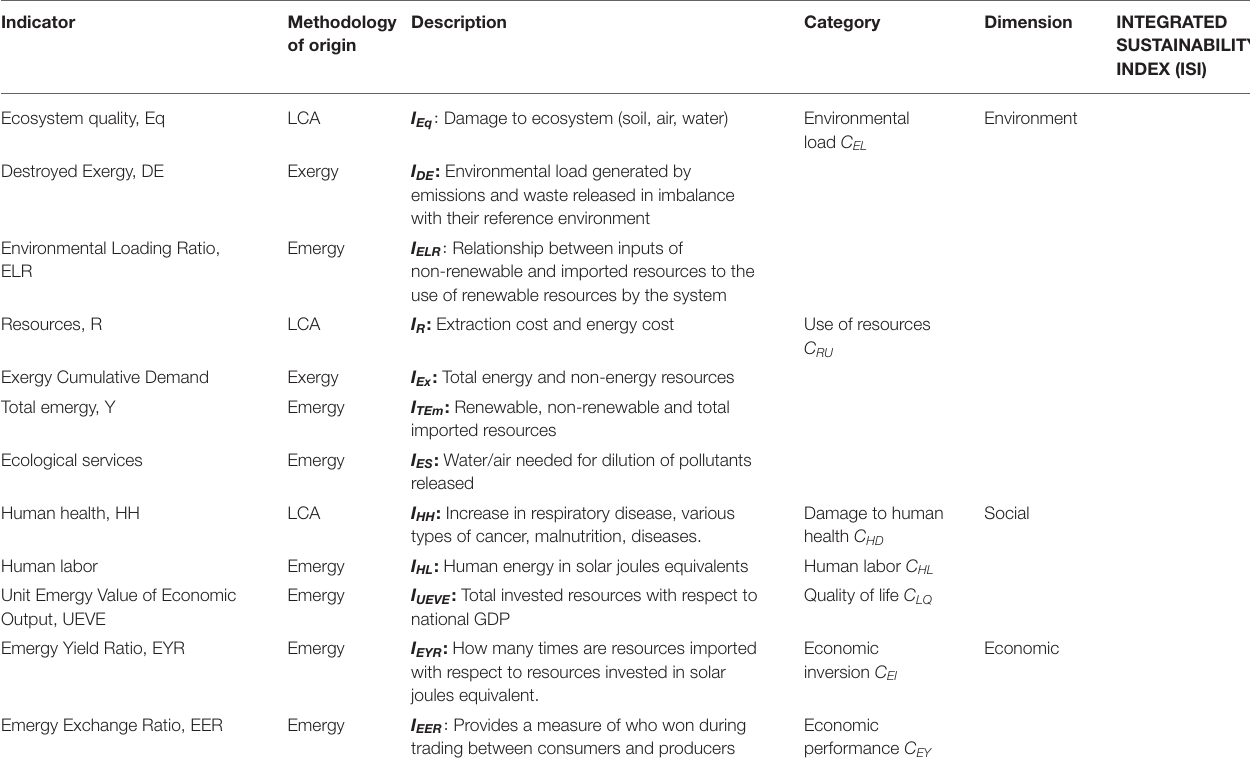
TABLE 1 | Aggregation methodology indicators in categories, dimension, and Integrated Sustainability Index (ISI).